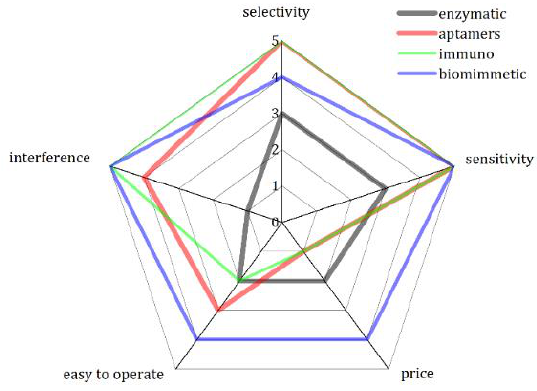
Figure 5. Spider diagram for the overall performance of different electrochemical biosensors for pesticide detection (1 — bad, 5 — very good). Remark: We do not consider sensors based on living